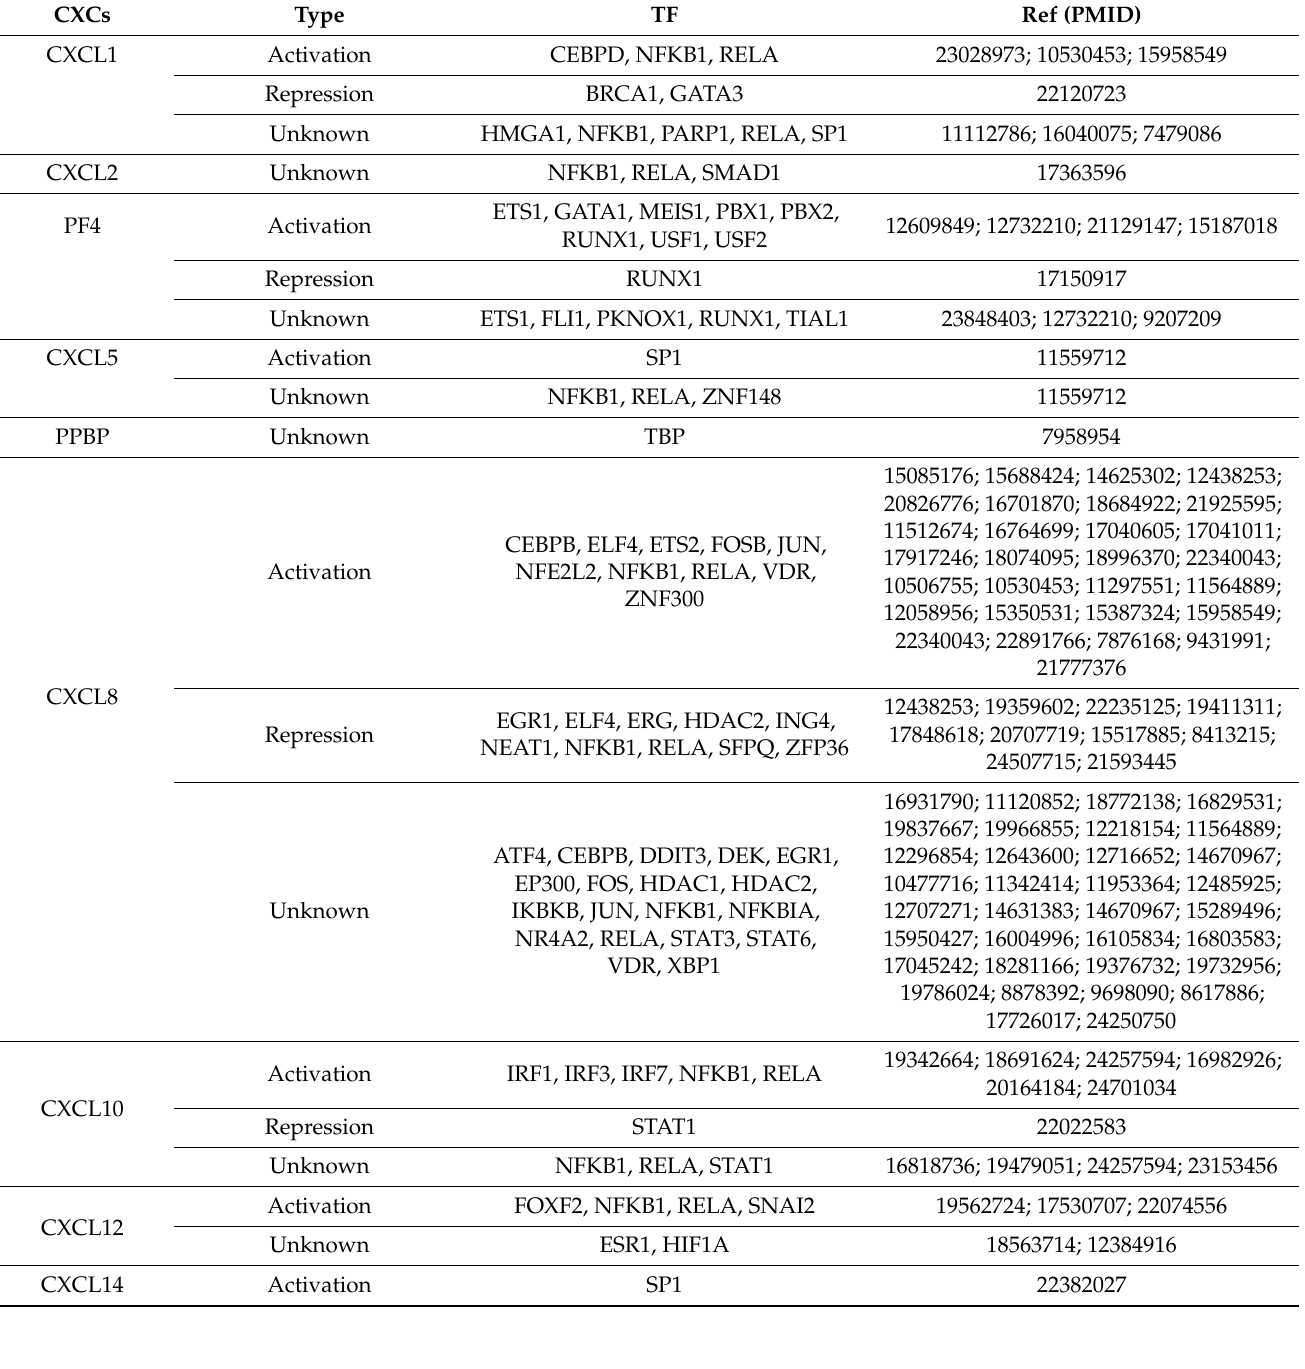
Table 3. TFs and regulatory relationships searched in TRRUST